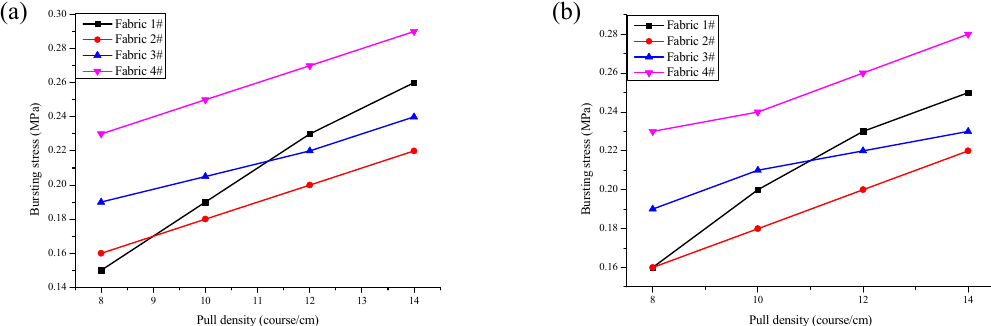
Figure 5. The relationship between the pull density and the bursting stress: ( a ) small warp run-in and ( b ) large warp run-in.